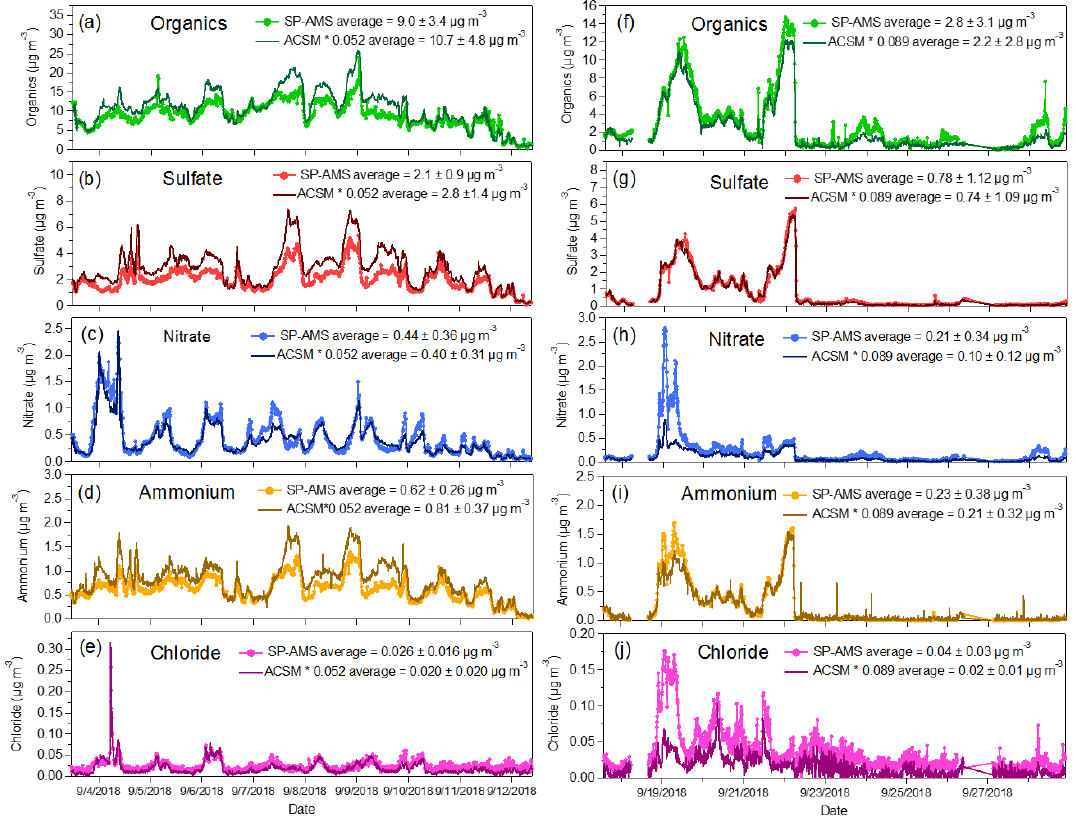
Figure 8. Ambient measurements at SMEAR III showing the mass loadings for organics (a, f) , sulfate (b, g) , nitrate (c, h) , ammonium (d, i) and chloride (e, j) measured with the SP-AMS and the ACSM + ADIc in high-flow ( a – e ) and low-flow ( f – j ) regimes. ACSM + ADIc data were corrected for the CF as described in the text. Spikes in the time series of ammonium in the ACSM are likely related to the detection of small air bubbles in the ACSM that affect the measured ammonium concentration.